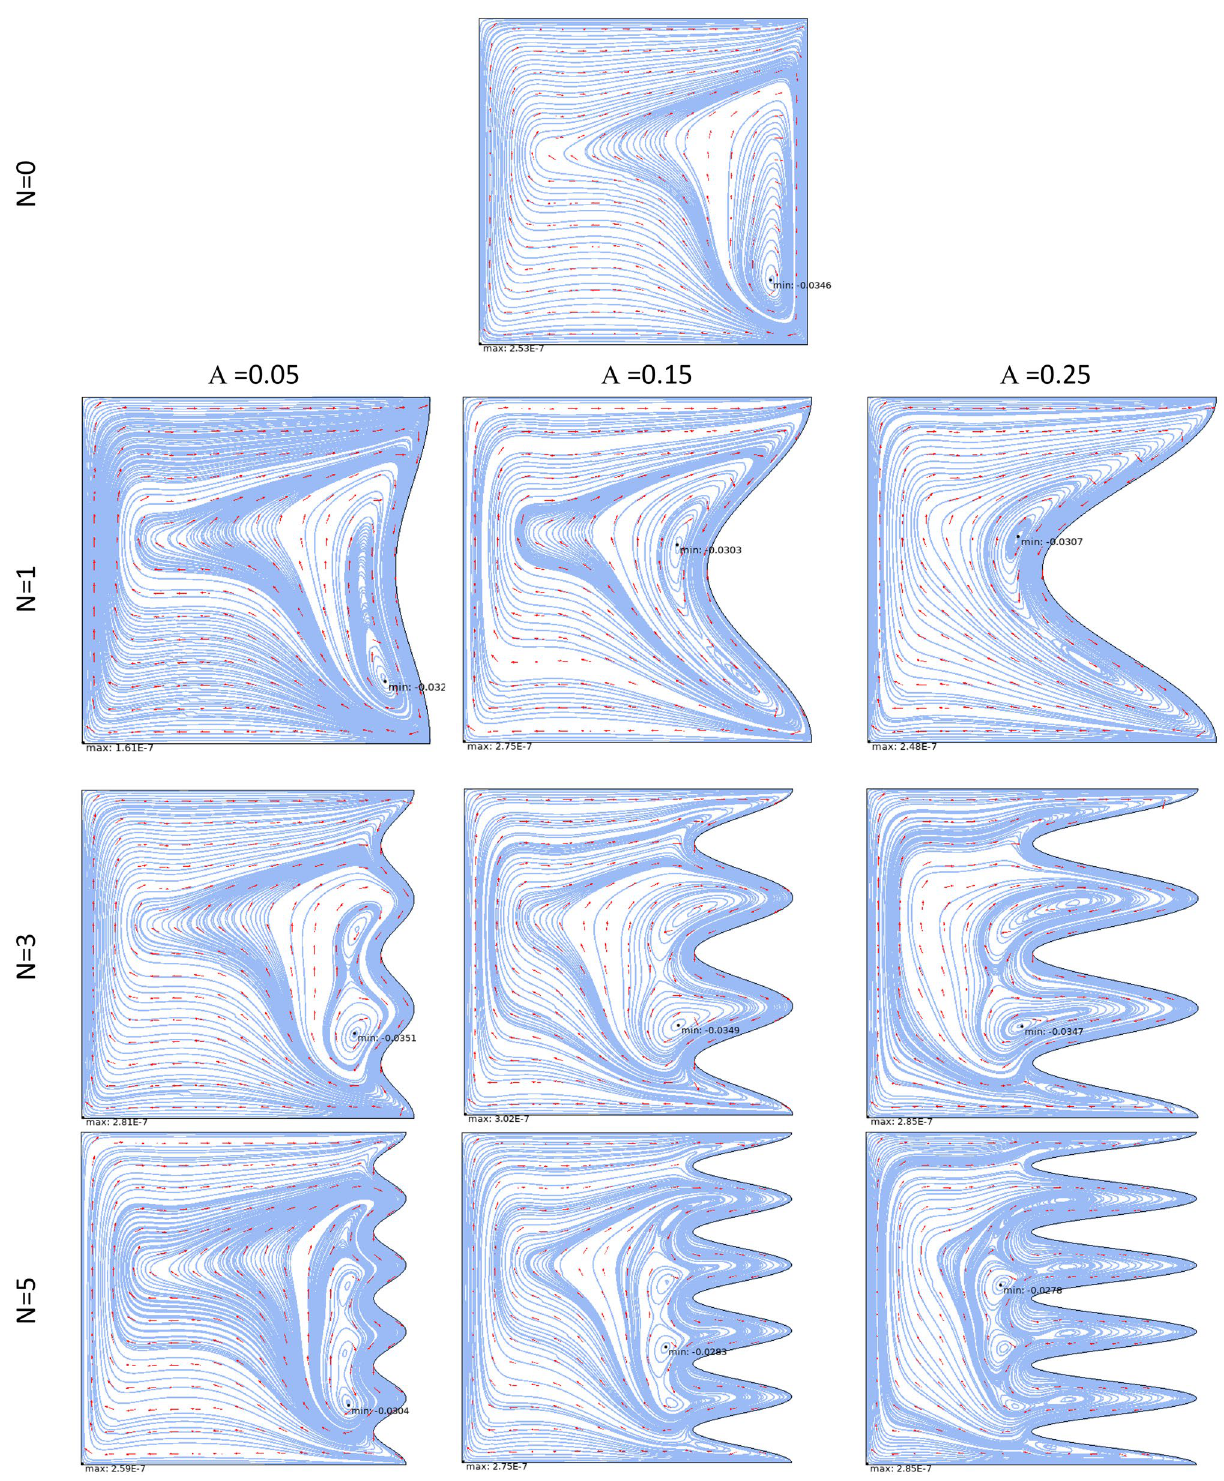
Figure 4. Streamlines and isotherms at (Da = 1e−3, Re = 100, λ = 5, φ = 0.03, Ha = 25, γ = 45, Ri = 10) for Case